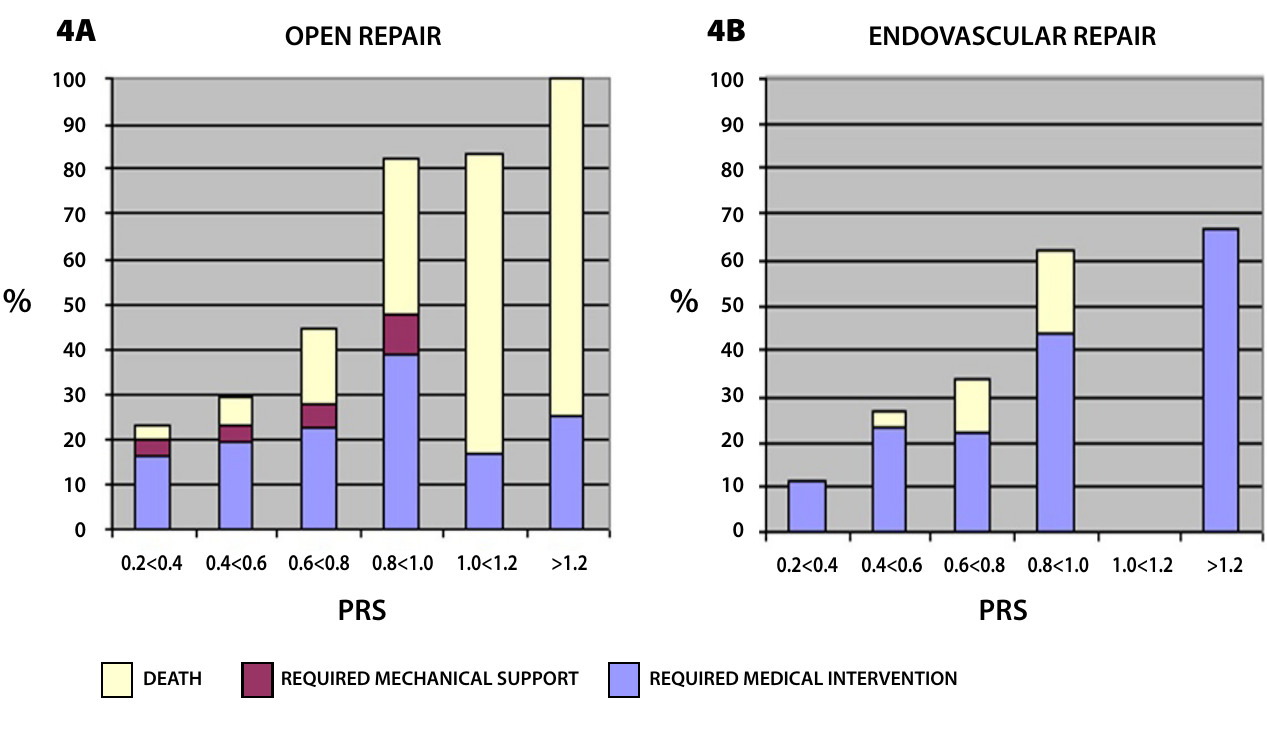
Fig. 4 - Percentage of patients that presented major postoperative complications or death in OR and EVAR groups, according to